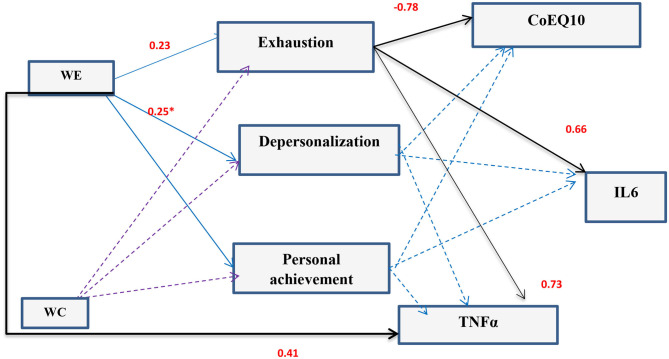
Path diagram of the model used for the whole critical specialty HCWs group for work addiction scores and burnout and pro-inflammatory markers (n = 81) (Multiple regression analysis using pathway analysis was applied). *significant.